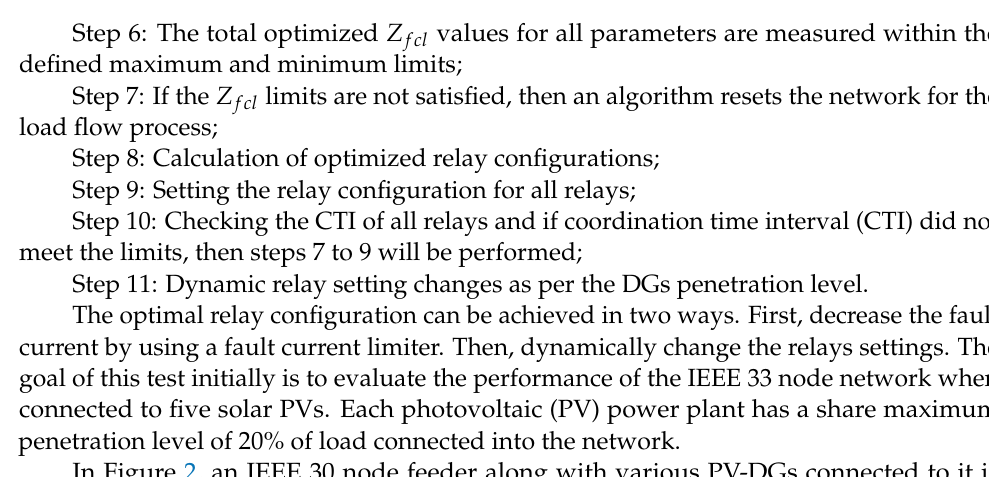
Z relay location representation. fcl